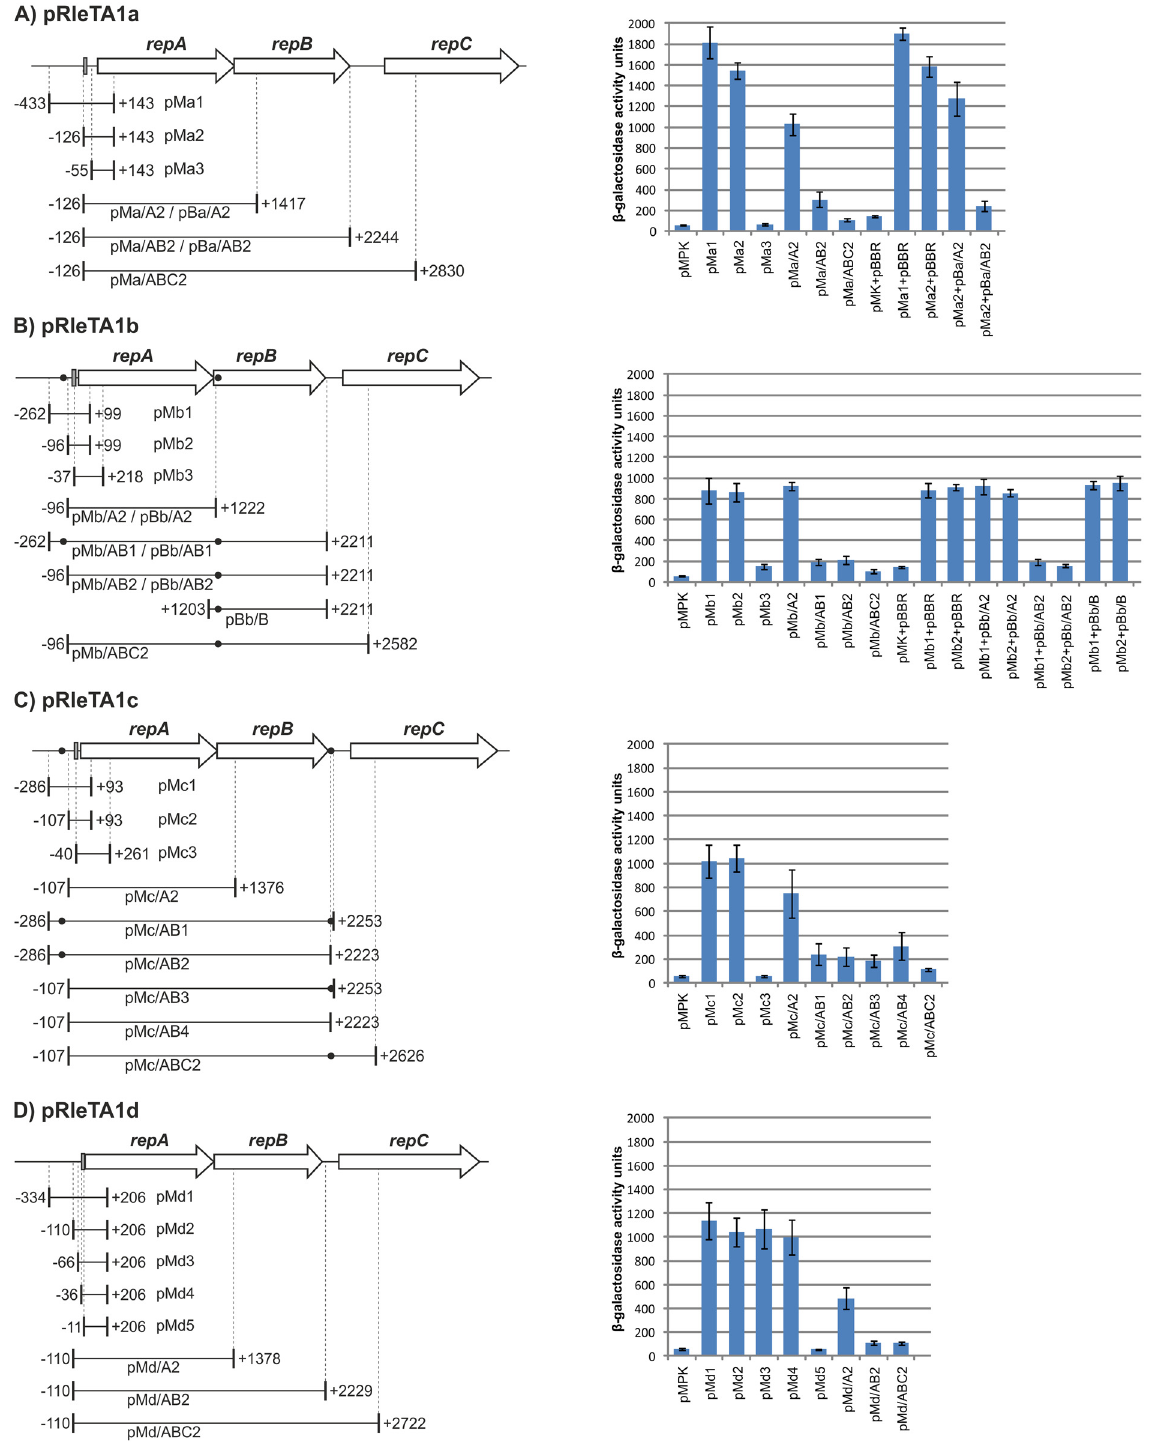
Fig 1. Transcriptional activity of repABC operons of Rhizobium leguminosarum bv. trifolii TA1 plasmids: (A) pRleTA1a, (B) pRleTA1b, (C) pRleTA1c, and (D) pRleTA1d. Left panels show schematic genetic organization of the repABC cassettes. White arrows represent repA , repB and repC genes, and white broken arrows depict repA genes. Black dots show the position of parS -sites. The identified promoters of repABC operons were marked as grey rectangular boxes. The respective DNA fragments necessary for particular promoter identification, operon structure assignment, as well as their sequential deletions used for operon regulation studies, which were cloned into pMPK reporter and pBBR1MCS-5 vectors, were shown as black lines with